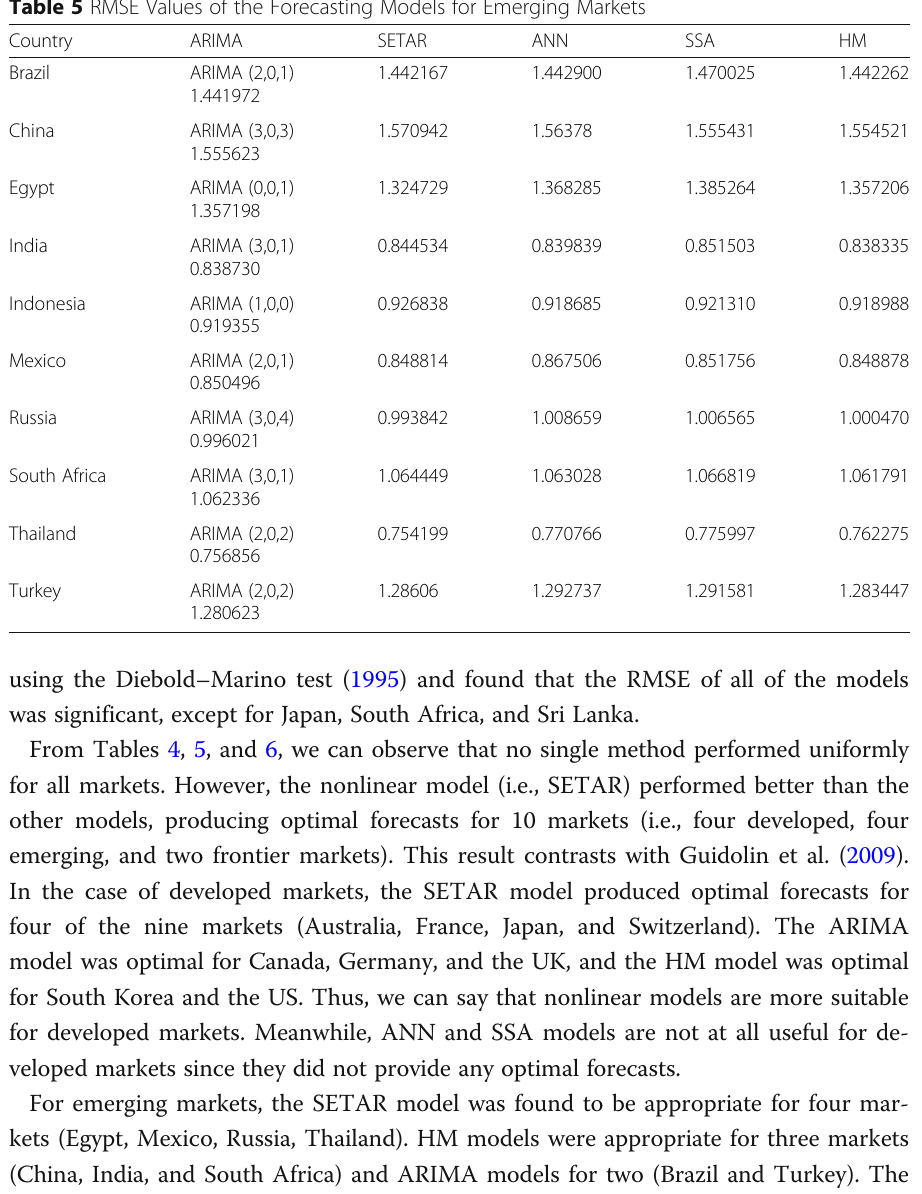
Table 6 RMSE Values of the Forecasting Models for Frontier Markets Country ARIMA SETAR ANN SSA HM